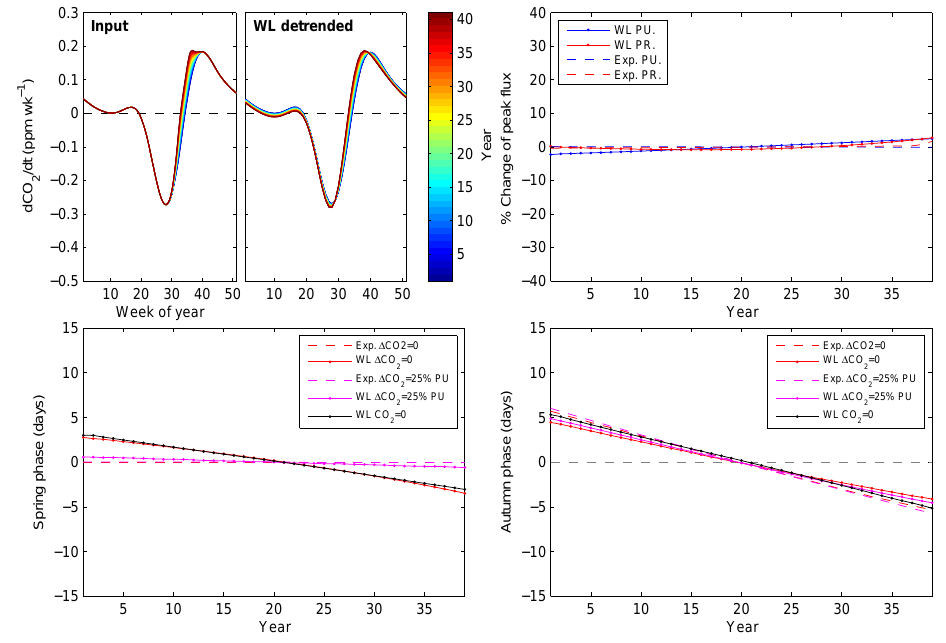
Figure B3. Same as Fig. B2 but including an earlier autumn onset of net CO 2 release.